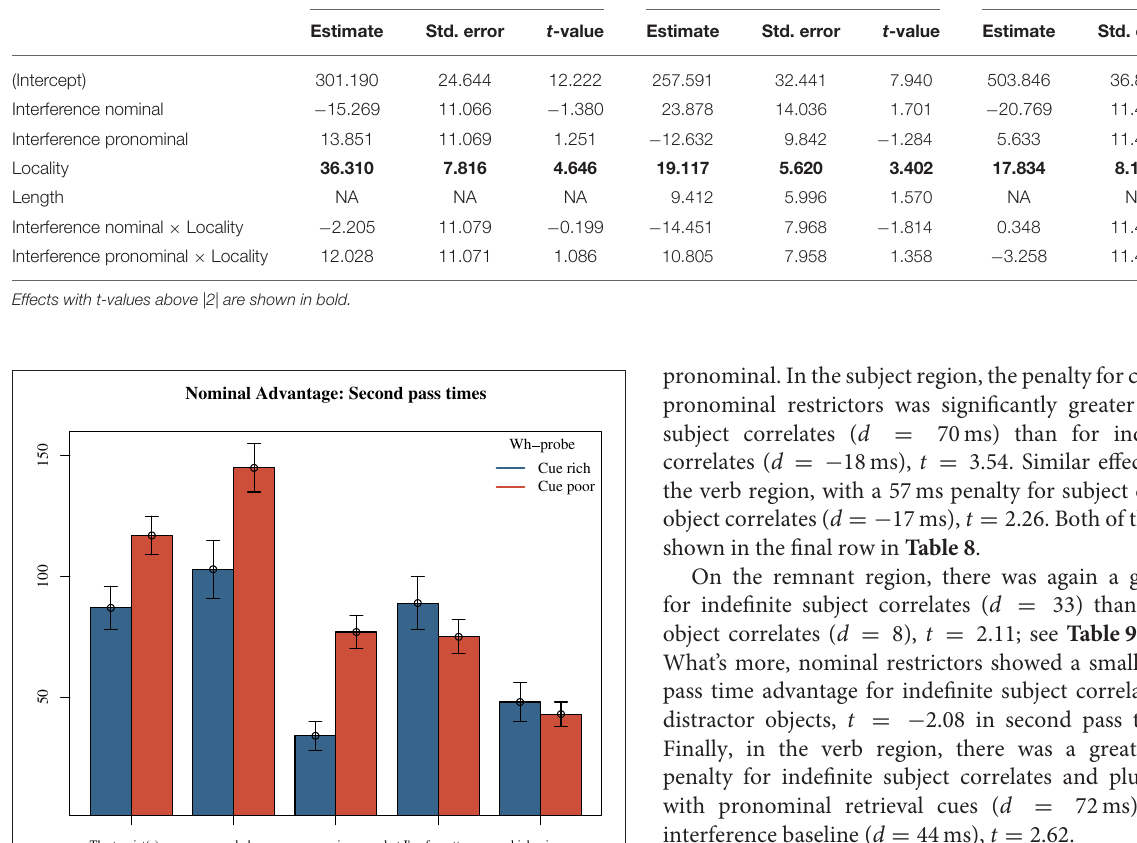
were also shorter total times for nominal probes in total times for the subject region ( M Nominal = 423 ms, SE = 17; M Pronominal = 485 ms, SE = 20), t = −